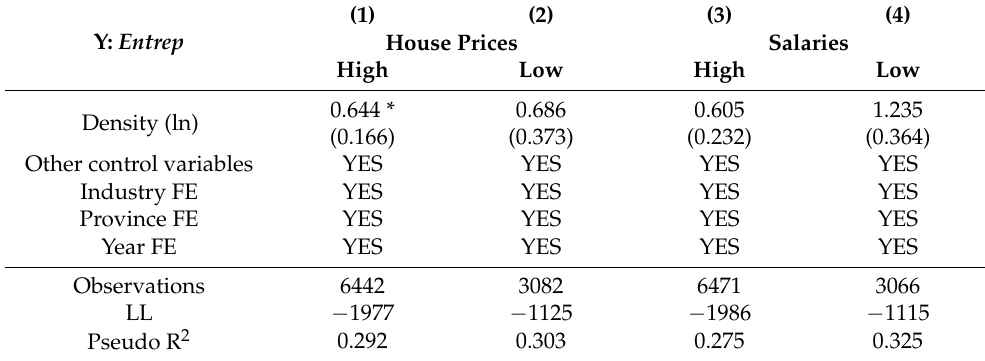
Table 6. Agglomeration and entrepreneurship: testing the effect of house price and salary.